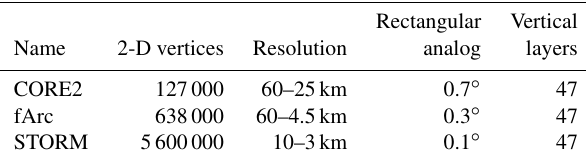
Table 1. Characteristics of the meshes. Rectangular analogs refer to Mercator-type grids with a similar number of wet